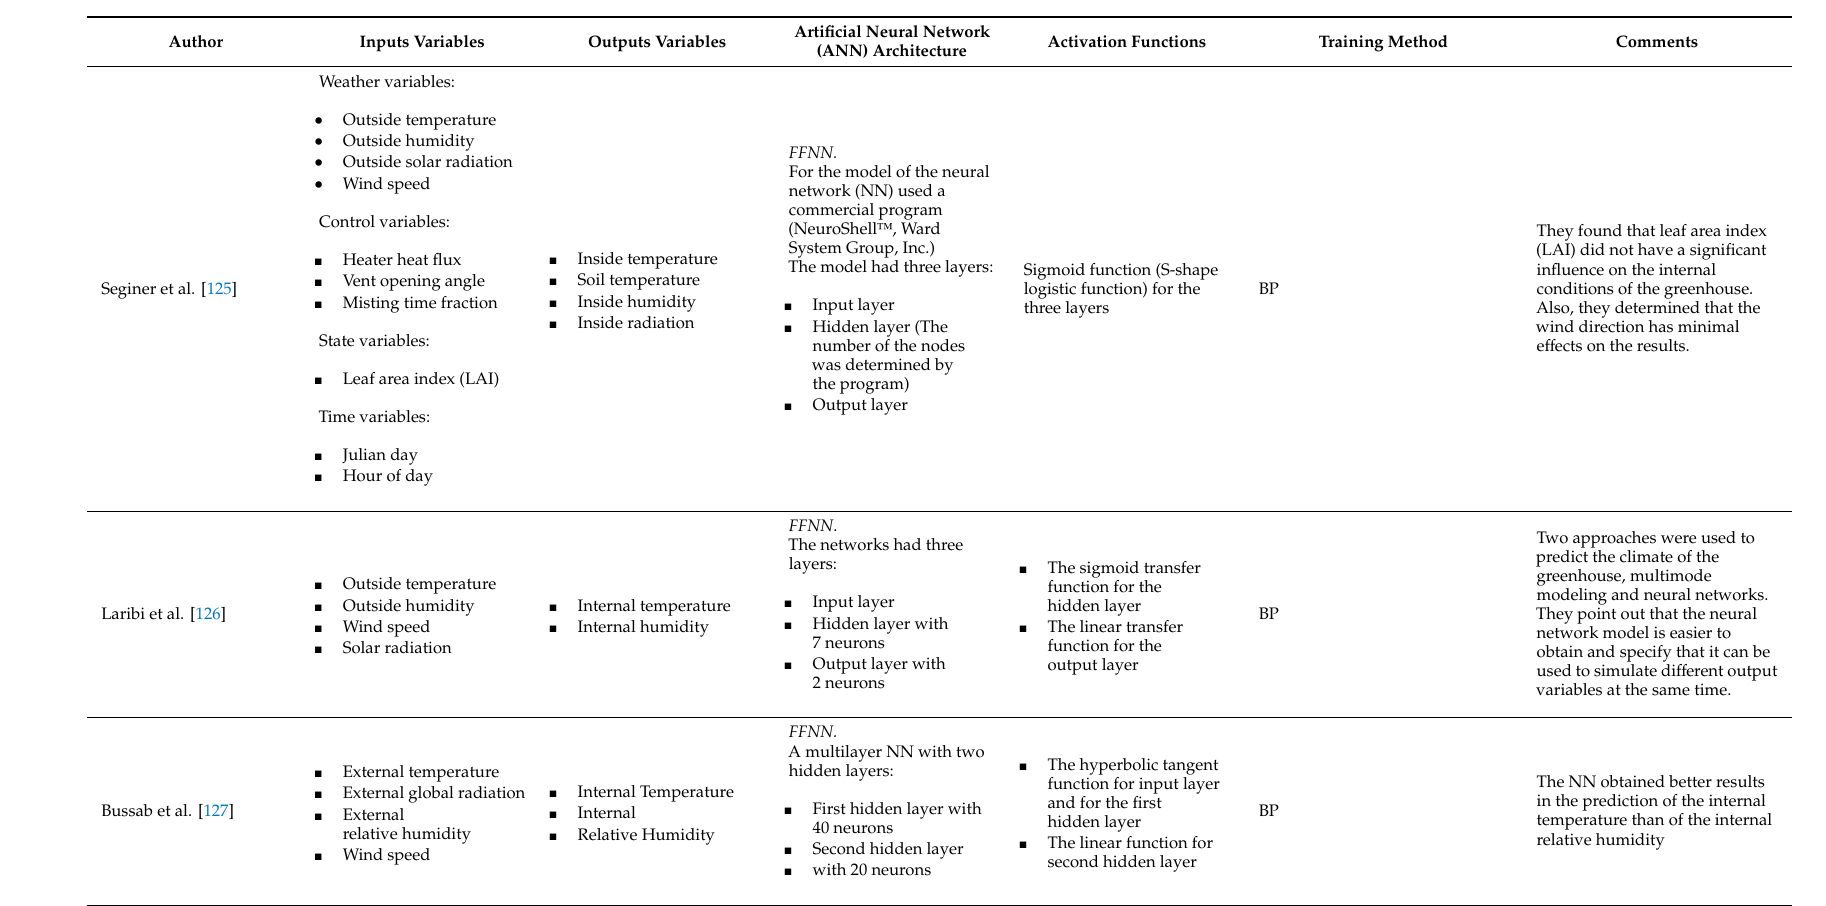
and for the first hidden